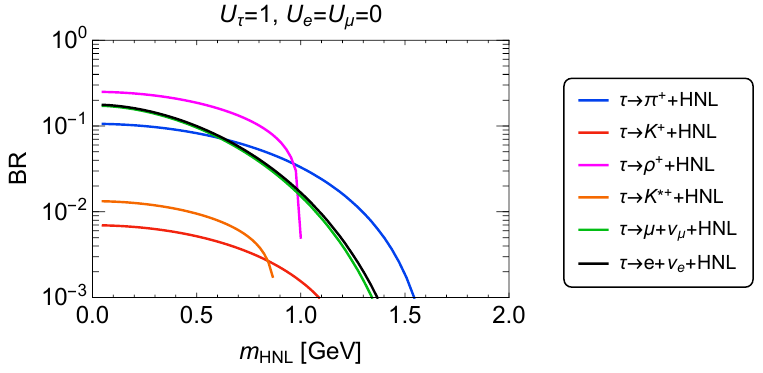
Figure 23 . The same plot as figure 21 but for U τ = 1 , U e = U µ = 0